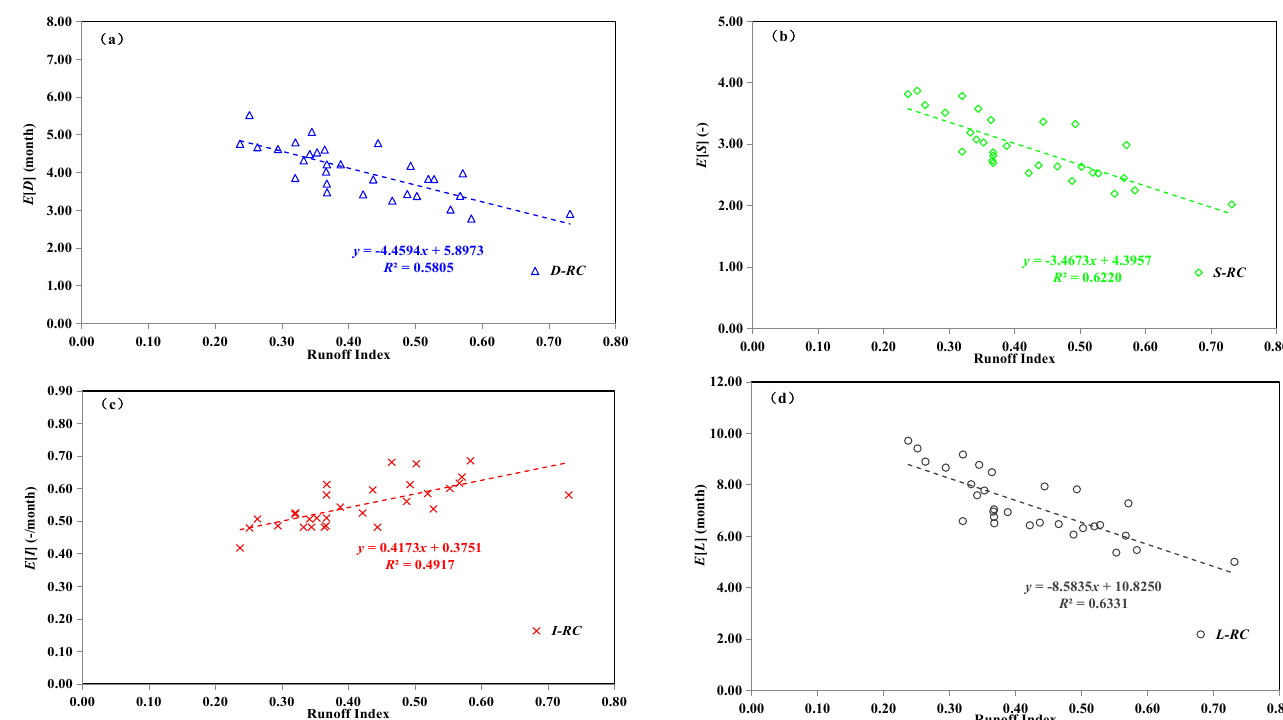
Figure 8. Correlation between Runoff Coefficient and ( a ) E [ D ]; ( b ) E [ S ]; ( c ) E [ I ]; ( d ) E [ L ]. Among the characteristics of each watershed climate and the underlying surface factors, the BI that reflects the watershed’s ability to regulate and store runoff, and the Runoff Coefficient RC that comprehensively reflects the climate and underlying surface elements, are most closely related to each drought feature, and the correlations between